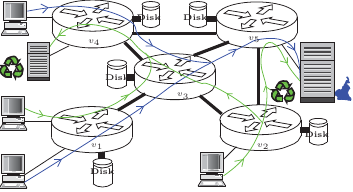
Figure 3: Two routing topologies and bidirectional